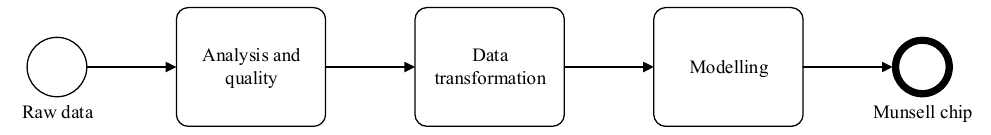
Figure 2. General flow of the proposed methodology.